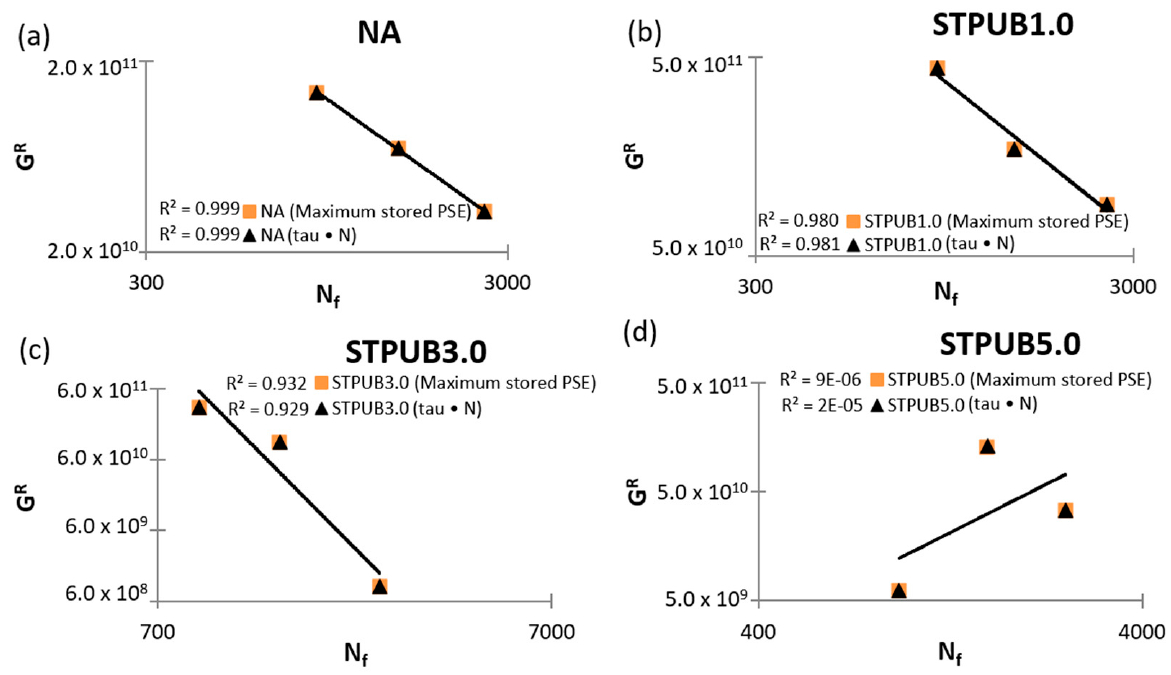
Figure 11. G R ( 𝑊 (cid:3045),(cid:3046)(cid:3048)(cid:3040)(cid:3019) ) vs. 𝑁 (cid:3033) failure criterion graphs: ( a ) NA, ( b ) STPUB1.0, ( c ) STPUB3.0, and ( d ) Figure 11. G R ( W R r , sum ) vs. N f failure criterion graphs: ( a ) NA, ( b ) STPUB1.0, ( c ) STPUB3.0, and ( d ) STPUB5.0.